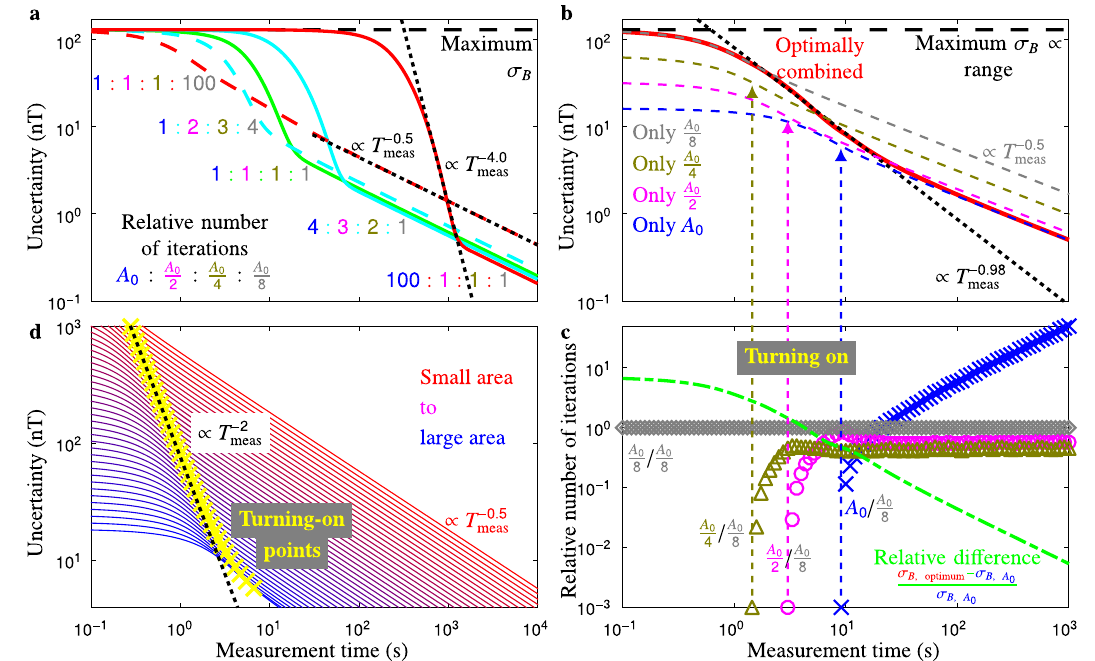
Fig. 3 Simulation analyses. a For different relative numbers of iterations of the subsequences (written directly left of each curve) of areas A , the uncertainty σ B with respect to measurement time T meas changes. Depending on the measurement time, a different combination gives the lowest uncertainty. b Minimised uncertainty for a large-range sequence by optimally combining the subsequences (red line). The dashed lines give the uncertainty for single-area sequences ( A 0 blue, A 0 /2 magenta, A 0 /4 olive, A 0 /8 grey). See Supplementary Note 1 for maximum uncertainty ∝ range. c The relative number of iterations for each area ( A 0 blue crosses, A 0 /2 magenta circles, A 0 /4 olive triangles, A 0 /8 grey diamonds kept at 10 0 ) for each measurement time to minimise the uncertainty, which results in the red line in b . The vertical arrows indicate when a subsequence for its area turns on, since its relative number of iterations becomes signi fi cant. The green dashed line gives the relative difference between the most-sensitive small-range sequence (blue dashed line in b ) compared to the optimally combined large-range sequence. This difference scales inversely with the measurement time. d When looking at the turning-on points (yellow crosses, fi t with black dotted line) for many sequences with different areas (largest area blue line, smallest area red line), it scales as T (cid:1) 2 for short measurement times. Please note that the optimally combined result in b scales as T (cid:1) 0 : 98 , since it includes relatively large areas meas meas only, equivalent to the lowest lines in this